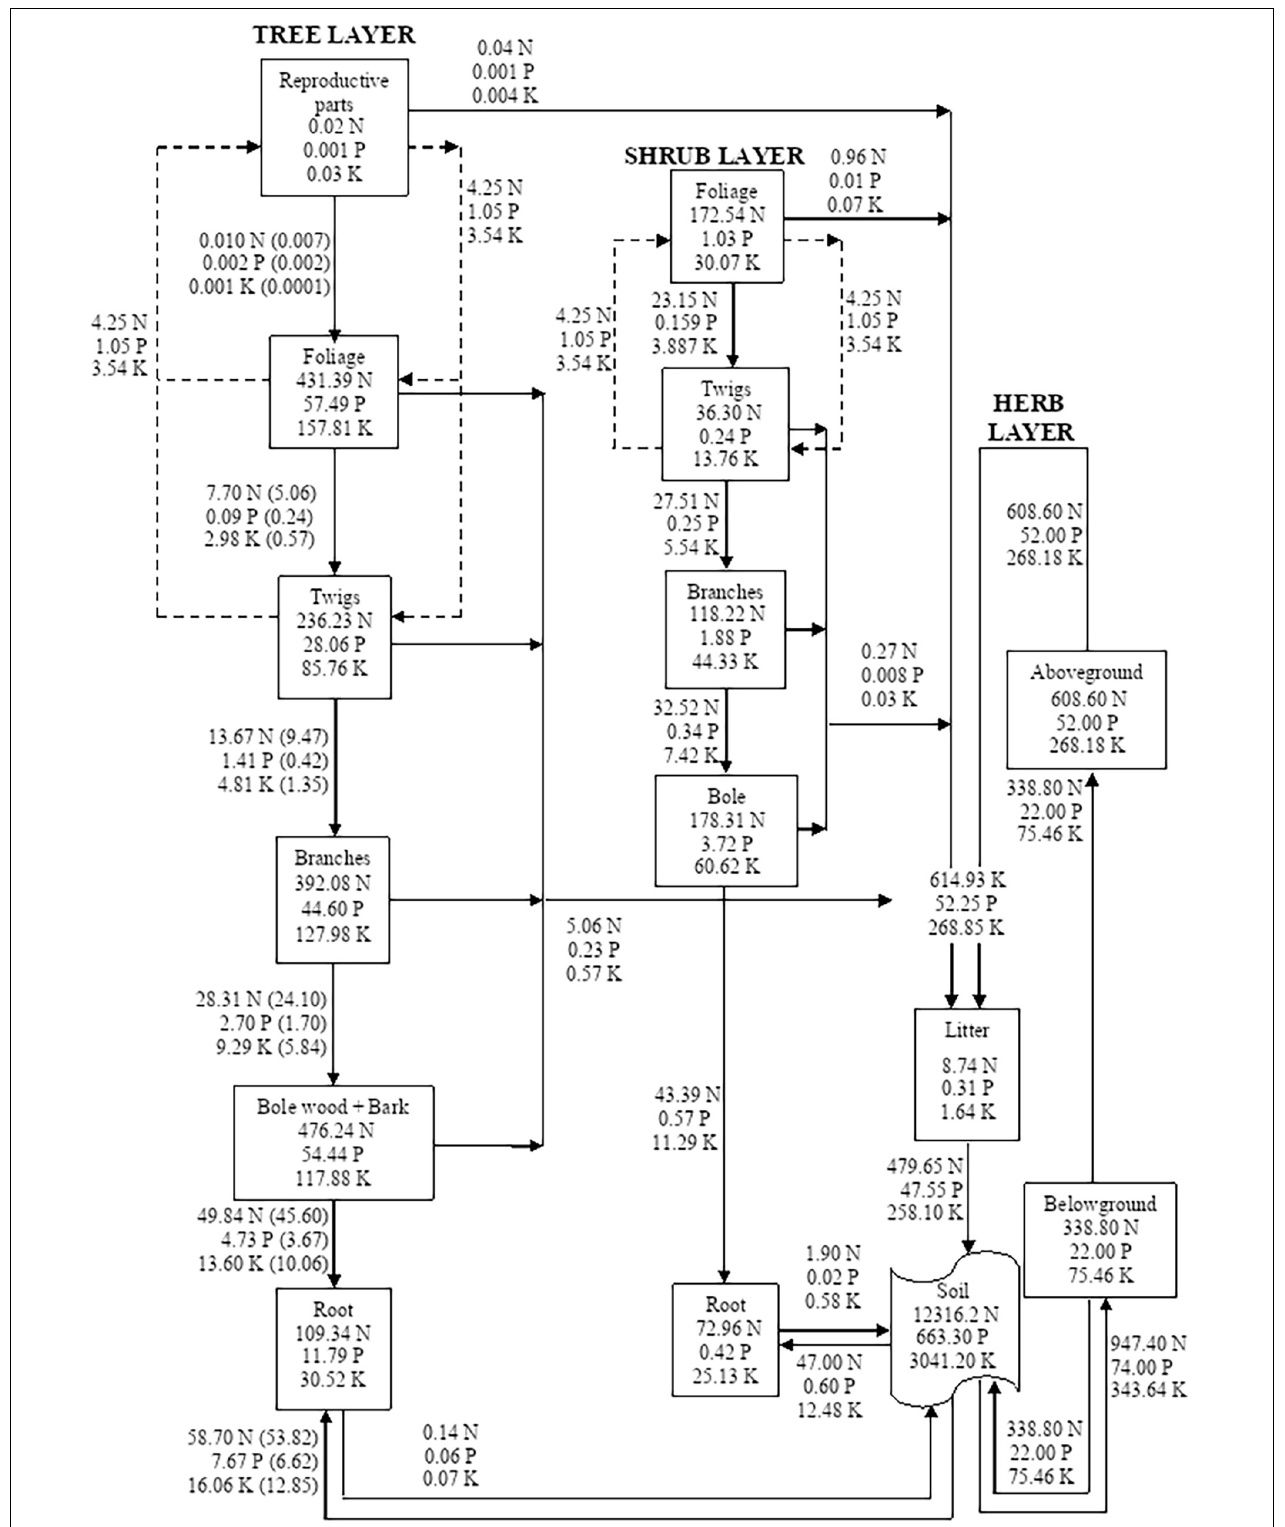
FIGURE 3 | Compartment models showing the distribution and cycling of nitrogen (N), phosphorus (P), and potassium (K) in tree, shrub, and herb at site-3. Rectangle represents a compartment for the standing state of nutrients from one compartment to the next compartment. Units are kg ha − 1 yr − 1 for flows between compartments. Values in parenthesis are after adjustment for internal cycling. Recycling between reproductive parts, foliage, twigs, and bole is shown by dotted lines.